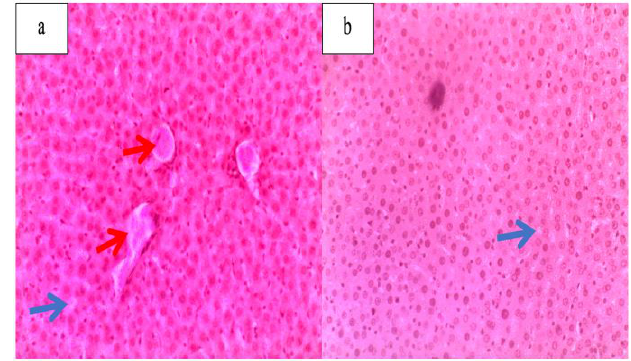
Fig. 3: Histopathological examination of rat liver (a-b): group 3 at 250mg/kg shows mild degenerative changes of hepatocytes blue arrow, congestion of portal vein red arrow shows in (a). Group 2 at 100mg/kg, showing mild degenerative changes of hepatocytes (fatty changes) blue arrow (b). H&E, 400X.